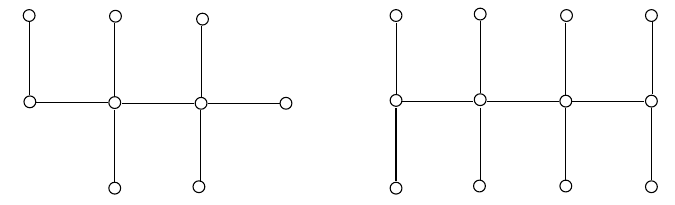
Figure 3: A 2-twin caterpillar and a 4-twin